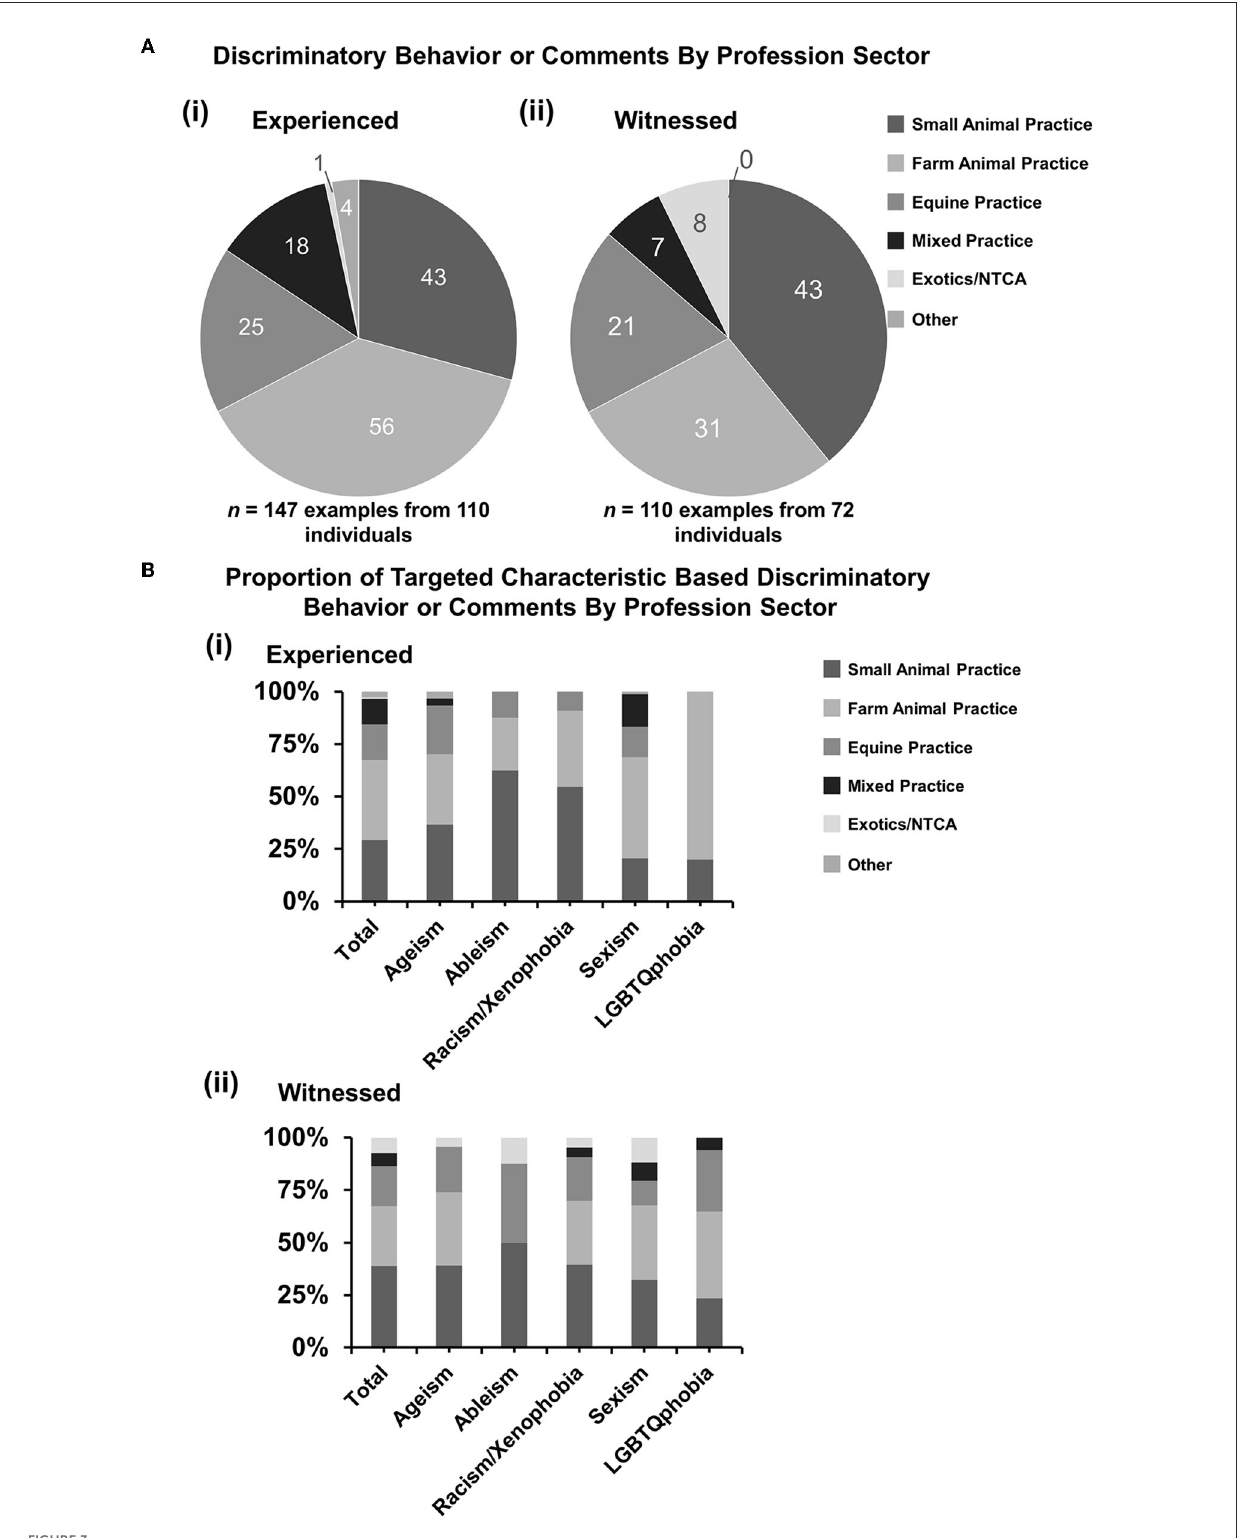
FIGURE3 Discriminatory behavior or comments experienced or witnessed by profession sector. Respondents who had responded “yes” or “not sure” were asked questions to select the profession sectors where clinical EMS was undertaken when the discrimination was experienced or witnessed: small animal practice, large animal practice (production animals), equine, mixed practice, exotics and non-traditional companion animals (NTCA), or other. Some respondents had experienced multiple incidents at different EMS placements. [ (A) i, ii] Pie charts demonstrating a number of selections under profession sector categories for (i) experienced ( n = 147 examples from 110 individuals) and (ii) witnessed ( n = 110 examples from 72 individuals) incidents. [ (B) i, ii] Percentage proportions of examples by discrimination types. Statistical significance was determined by Pearson’s chi-squared test of association between total proportions and matching proportions for each category. No statistically significant associations were identified. And 95% confidence intervals have been left off for figure